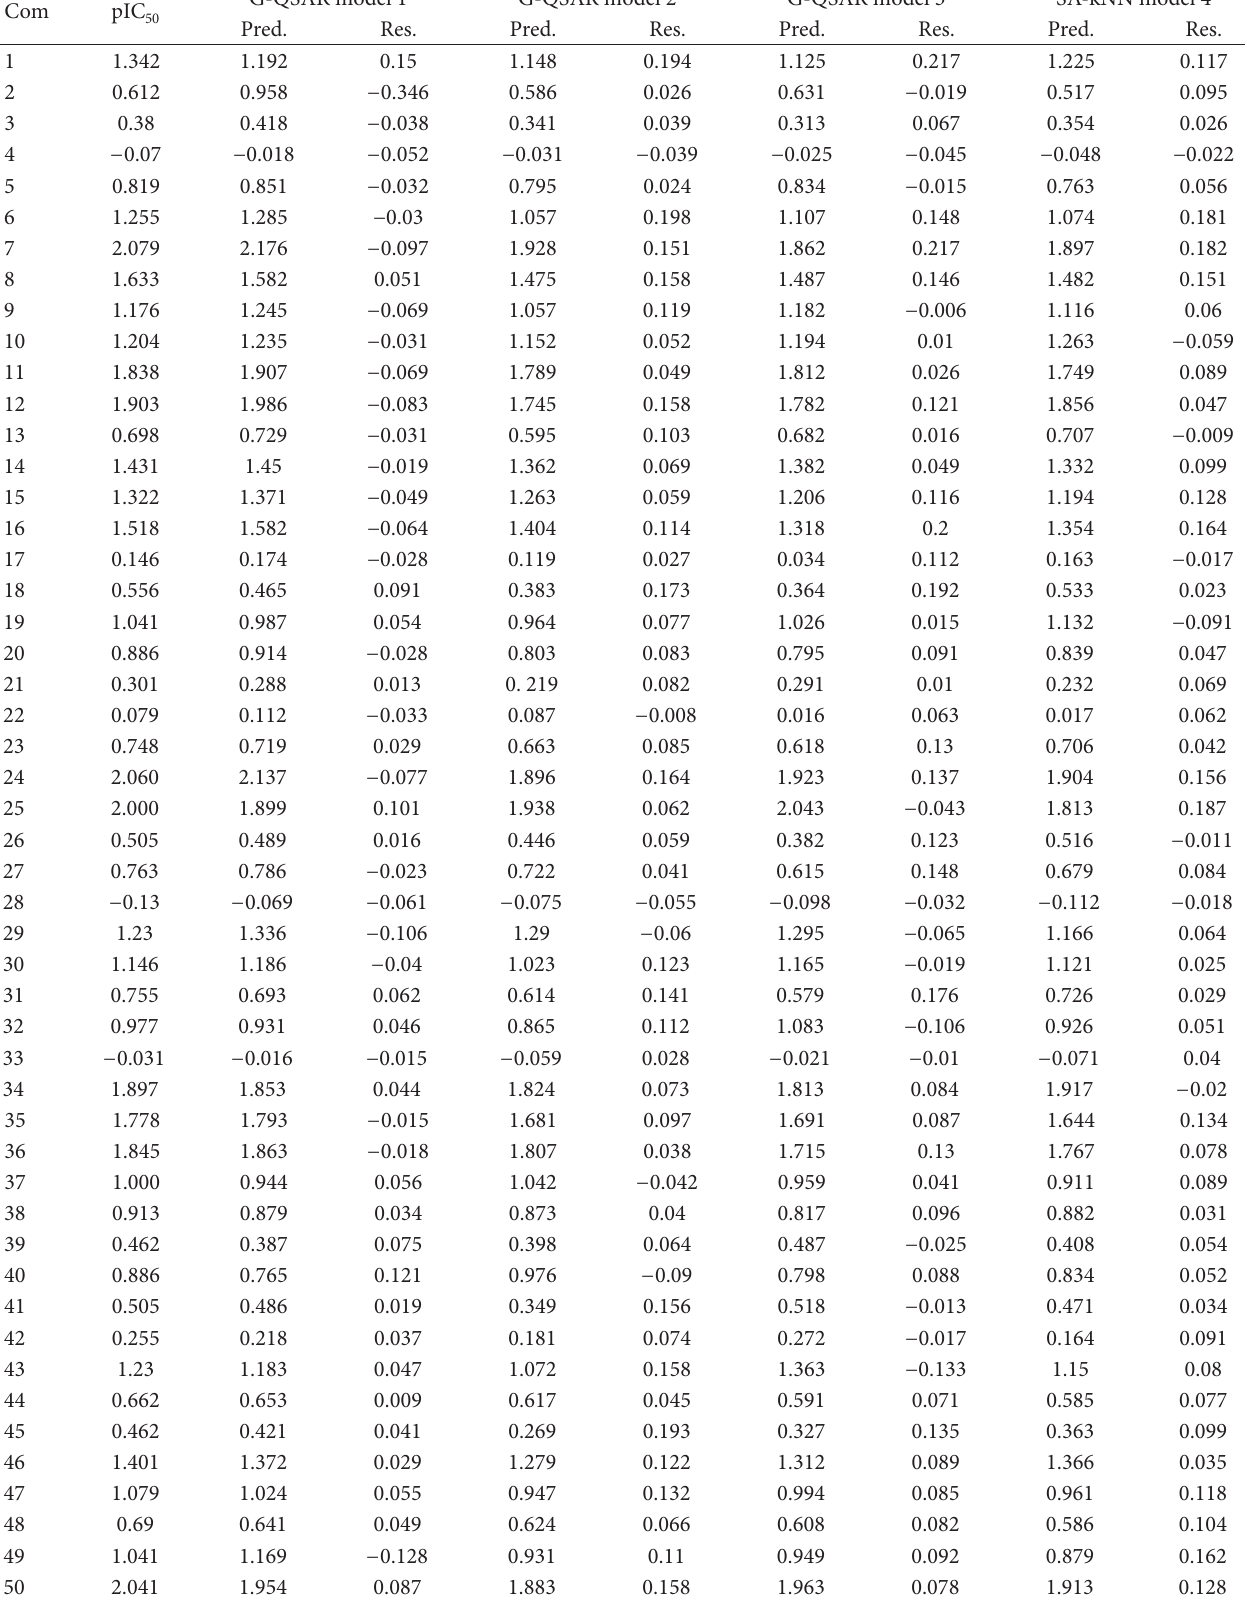
T 3: Comparative observed and predicted activities (LOO) of triazolinone aryl and nonaryl by best 3D-QSAR